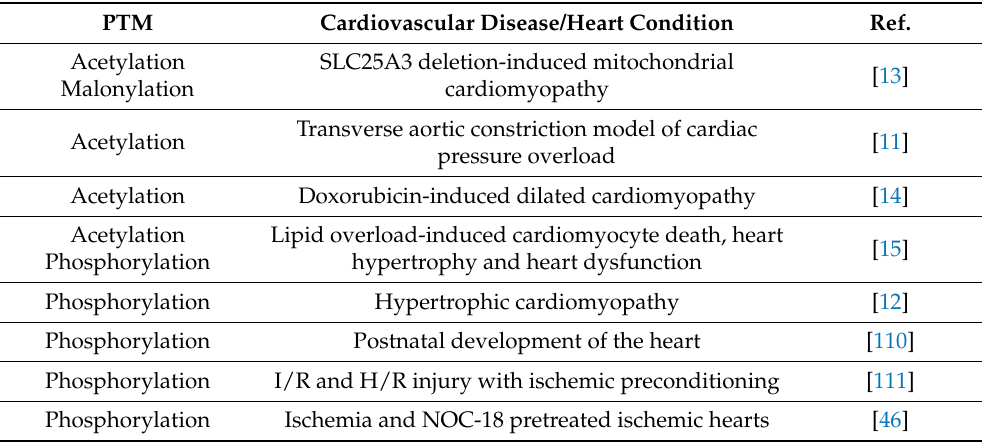
Table 2. The studies of PTMs (acylation and phosphorylation) in various cardiovascular diseases and in other heart conditions that were discussed in detail in Section 4. PTM Cardiovascular Disease/Heart Condition